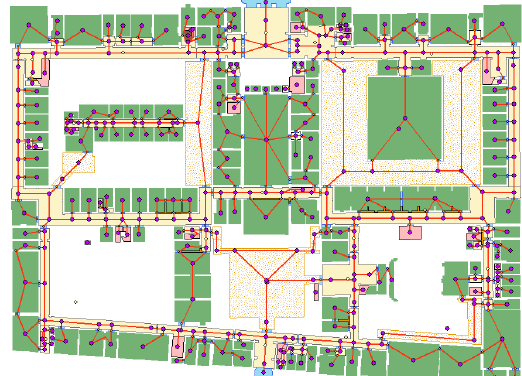
Figure 1: Floor plan of the ground floor with network